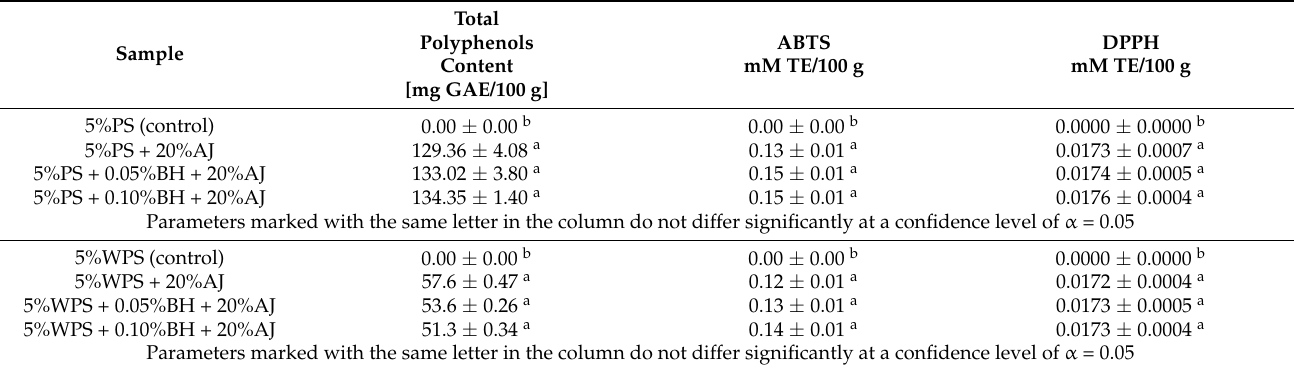
Table 8. Total polyphenol content in samples with normal and waxy potato starch, buckwheat fiber and juice.